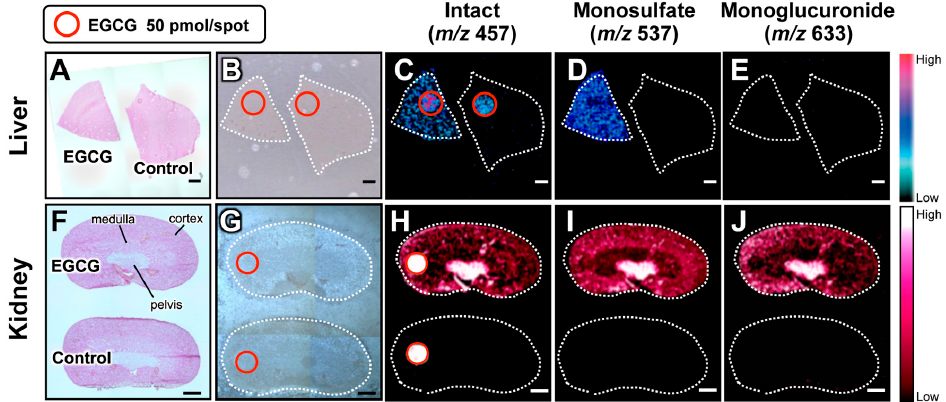
Figure 2. In situ label-free visualization of an orally-dosed EGCG and its phase II metabolites in tissue micro-regions. Simultaneous visualization of EGCG and its phase II metabolites in ( A – E ) liver and ( F – J ) kidney sections. Images ( A , F ) show H & E staining; ( B , G ) show optical microscopy, and the other images are for MALDI-MS of EGCG ( m / z 457) ( C , H ); EGCG-sulfate ( m / z 537) ( D , I ), and EGCG-glucuronide ( m / z 633) ( E , J ). An additional EGCG spot (red circle) was visualized as a positive, internal control. Adapted with permission from reference [5].